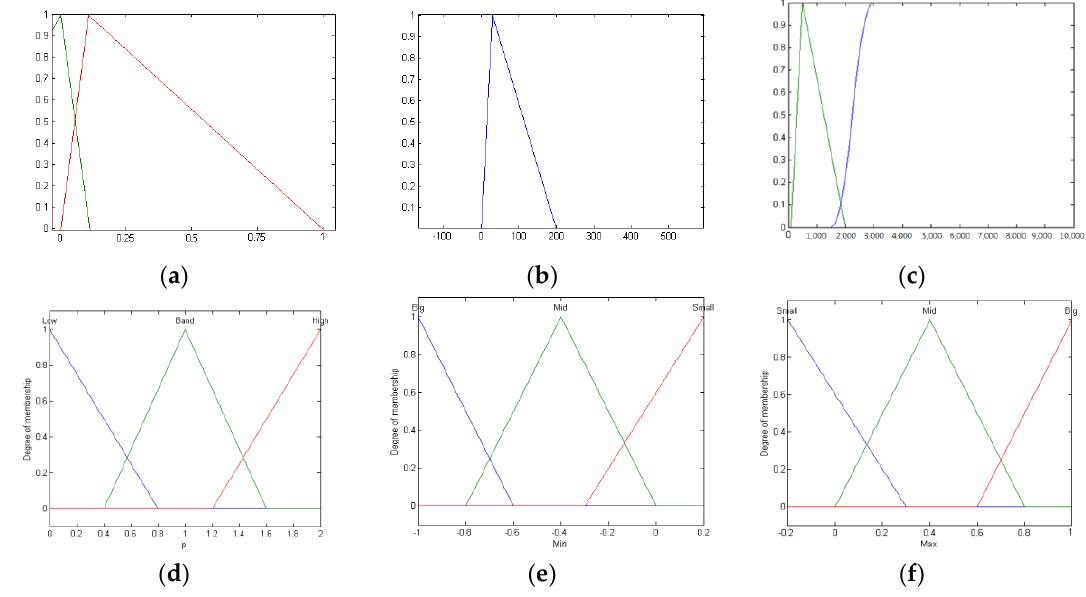
Figure 4. Membership functions of ( a ) E -MF1 and MF2, ( b ) E -MF3, ( c ) E -MF4 and MF5, ( d ) P , ( e ) Min , and ( f ) Max .